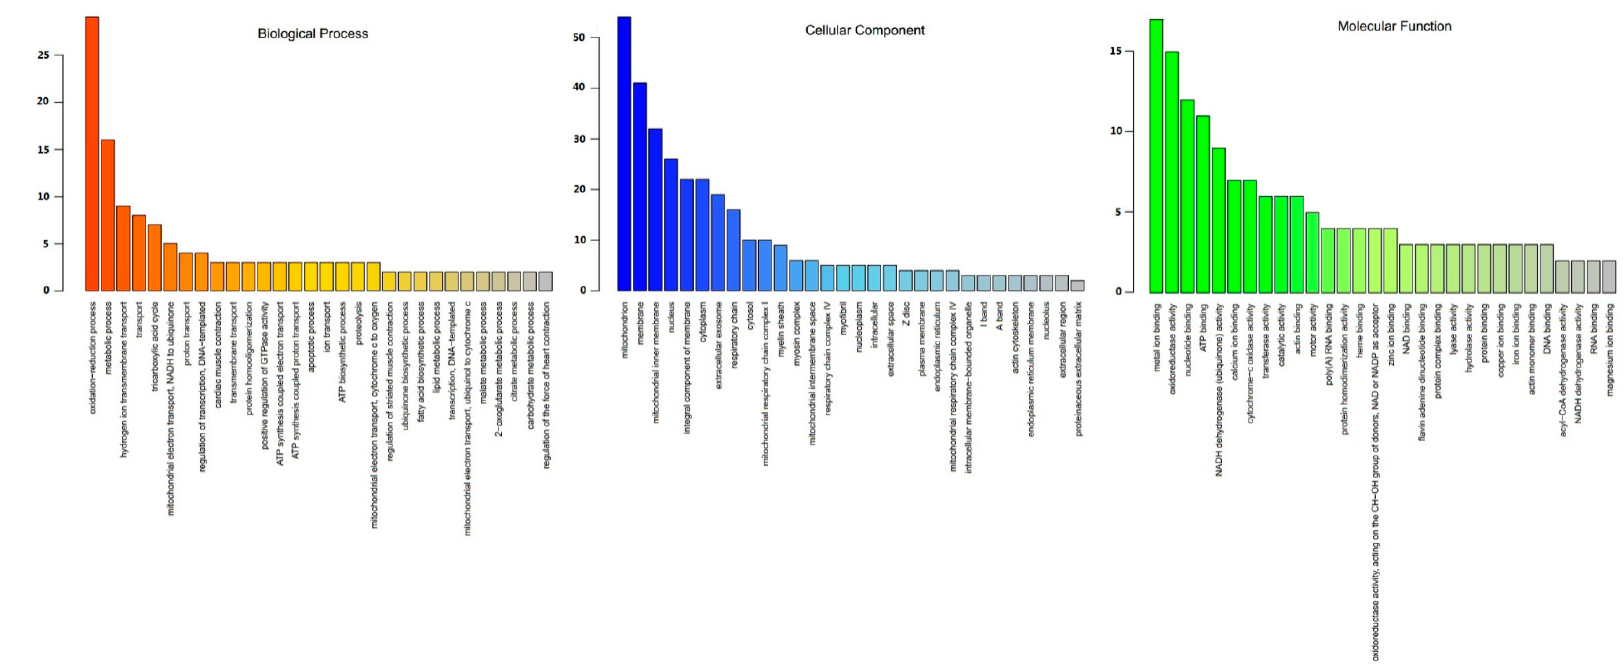
Figure 4. Gene ontology (GO) distribution of DEPs between tenderloin and flank steaks. DEPs are grouped into 30 categories according to biological process, cellular component and molecular function. The X-axis is the GO term, and the Y-axis is the number of differentially expressed proteins.